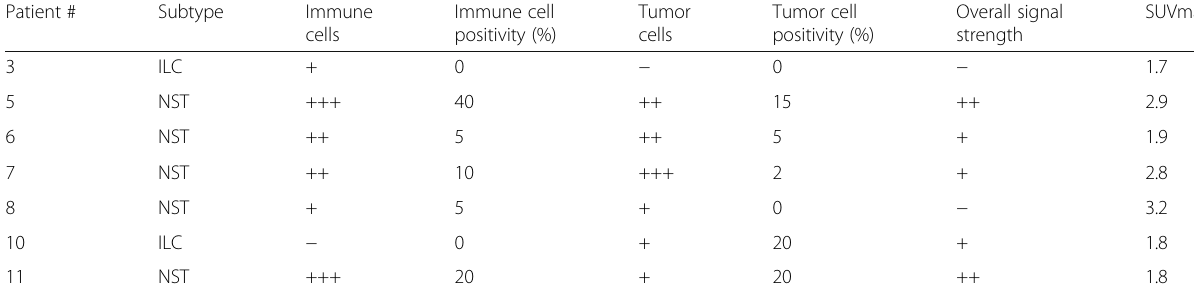
Table 3 Immunohistochemical assessment for CXCR4 in surgical specimens Patient # Subtype Immune